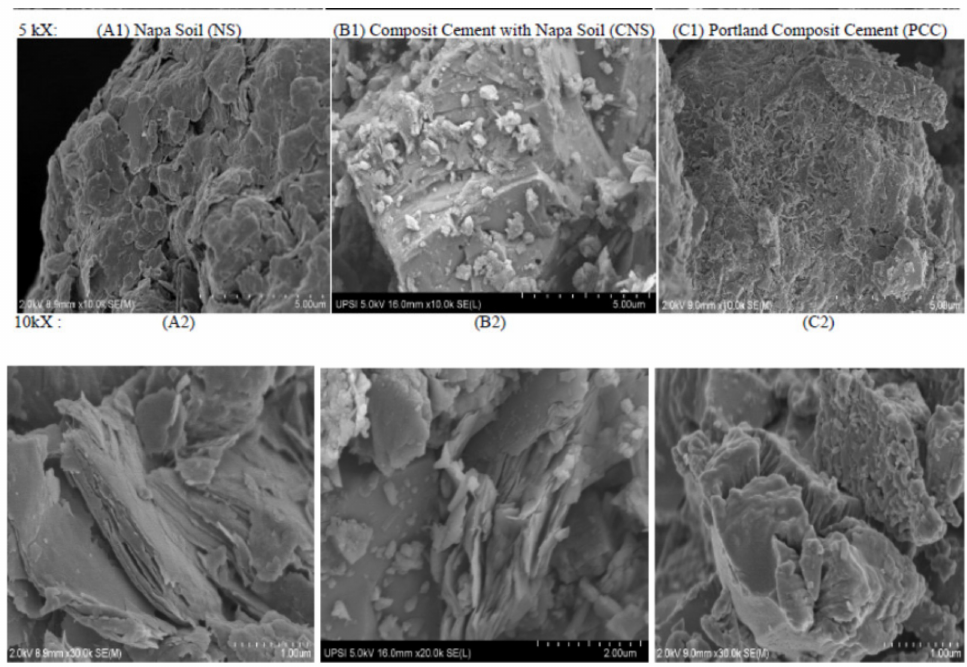
Figure 3. SEM image ( A ) Napa soil (NS), ( B ) CompositecCement with Napa soil (CNS) and ( C ) Portland composite cement